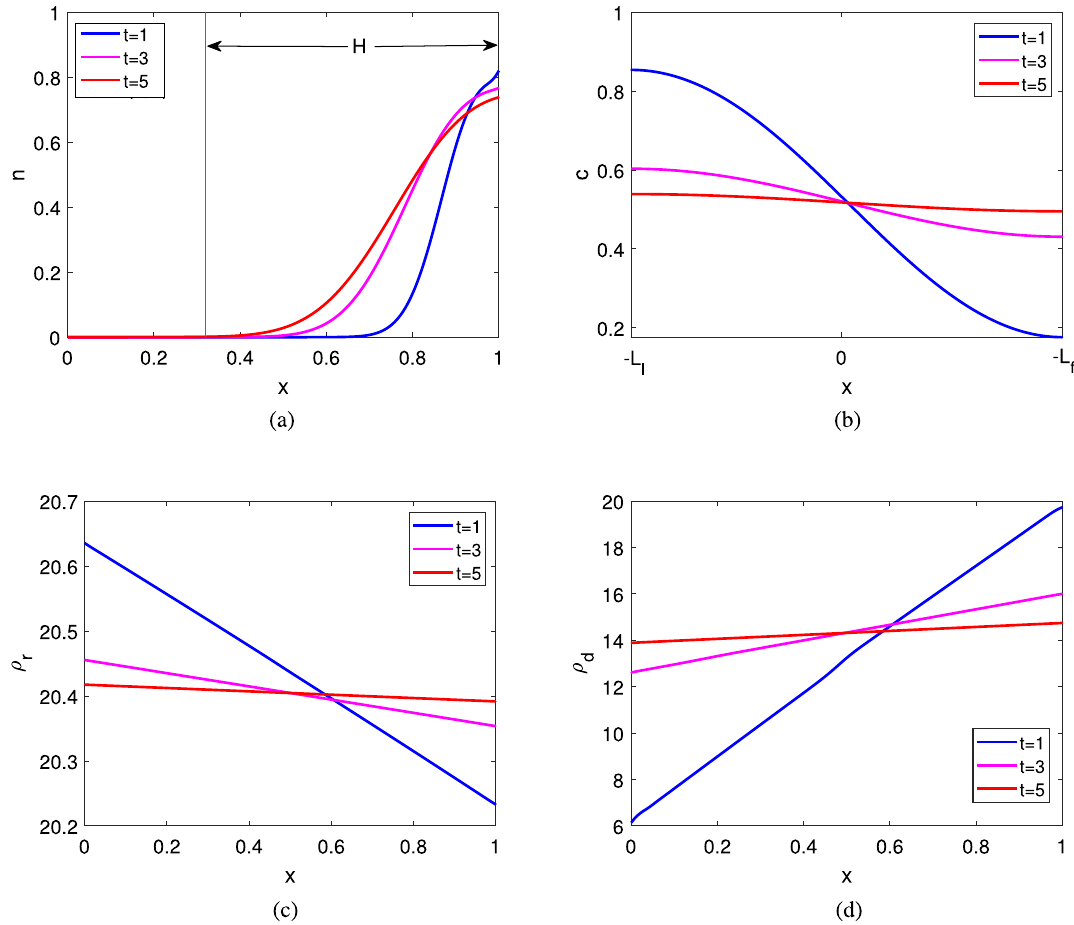
Figure 3. Solution for system (8-9) : ( a ) The distribution of cells in the filter, ( b ) ligand distribution in whole chamber, ( c ) distribution of normal receptors in the filter ( d ) distribution of decoy receptors in the filter at different times. Here β = 0.97 and δ = 0.952 . Other parameter values are given in Table 2.